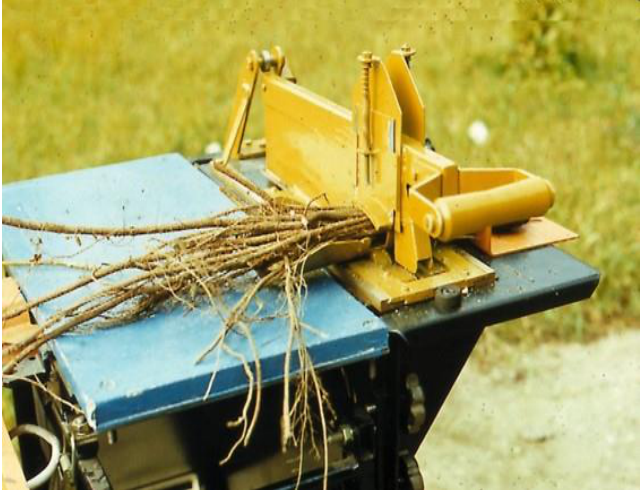
Figure 1. Black locust root